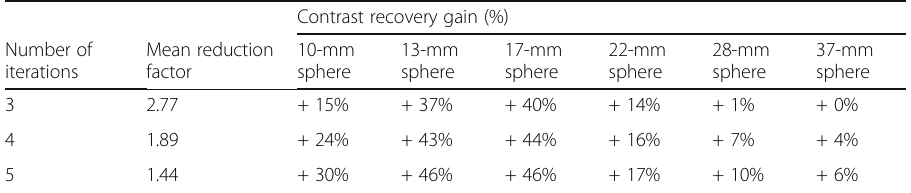
Table 5 Reduction factor and CR gain for different numbers of iterations (Vision with 220 × 220 matrix size) when compared to the reference values of